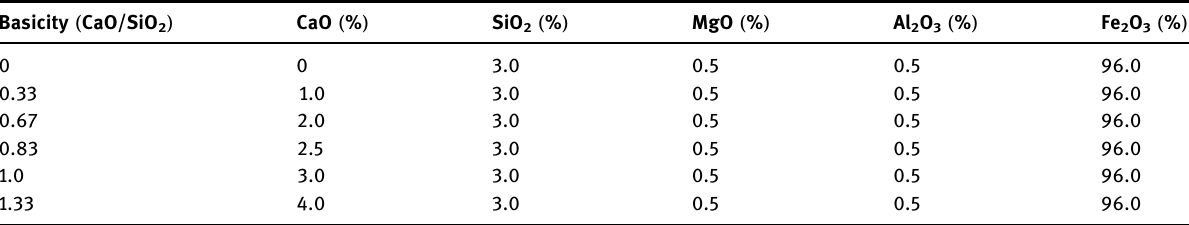
Table 1: Chemical ratio of briquettes at di ff erent basicity values Basicity ( CaO/SiO 2 )